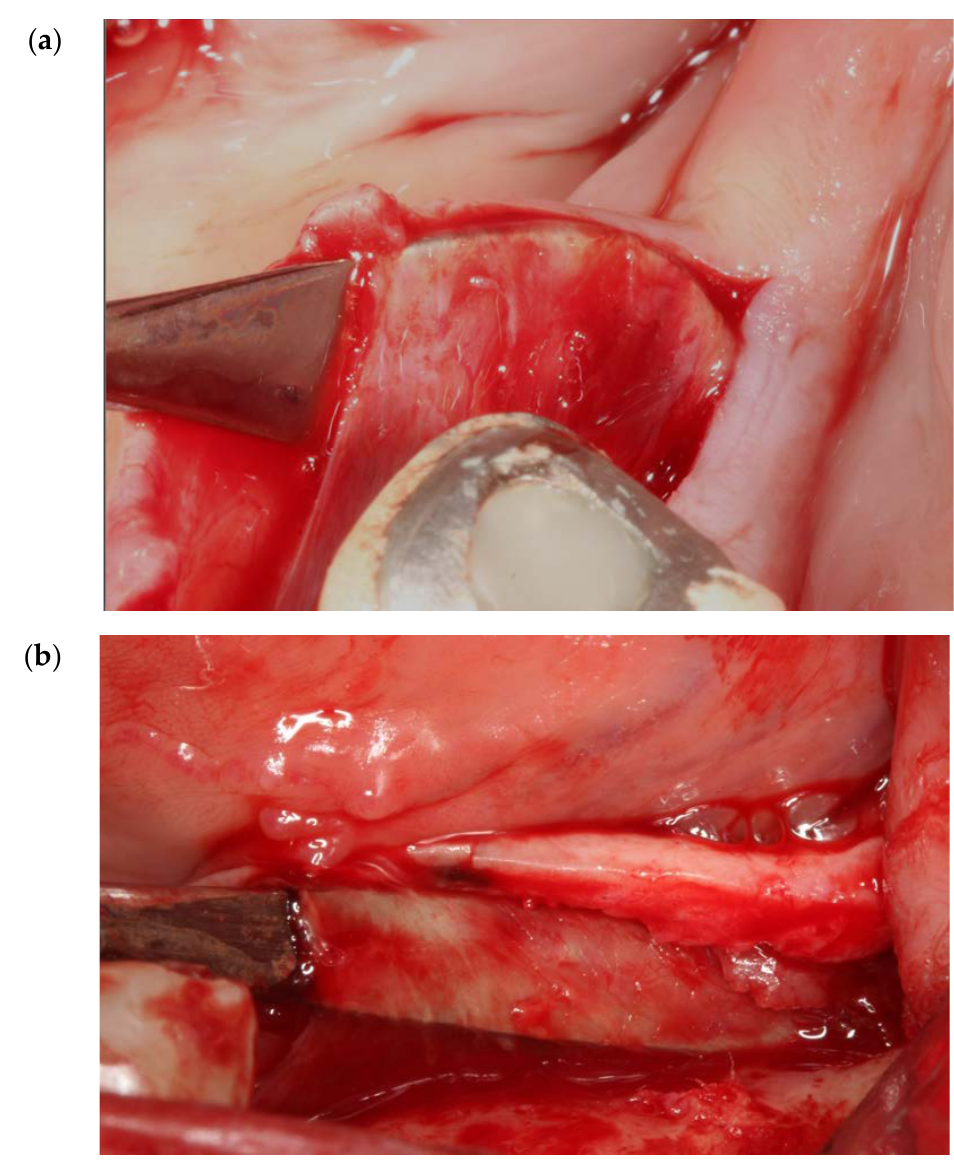
Figure 10. ( a , b ) Clinical overview of the placement of two different blunt instruments under the attachment of the mylohyoid muscle at the lingual flap. The connective tissue attachment ranges from 1–2 cm.